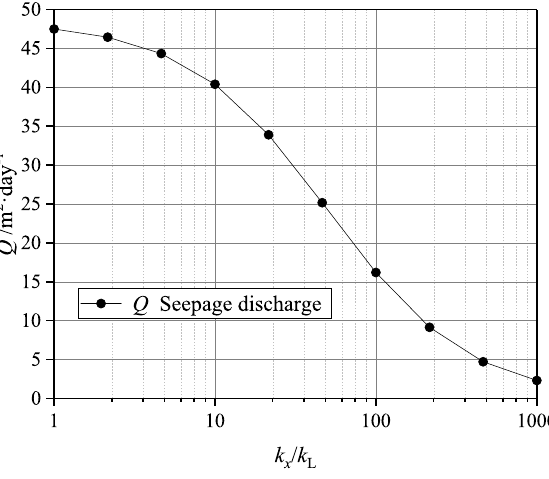
Figure 10. Seepage discharge under different permeability coefficient of lining